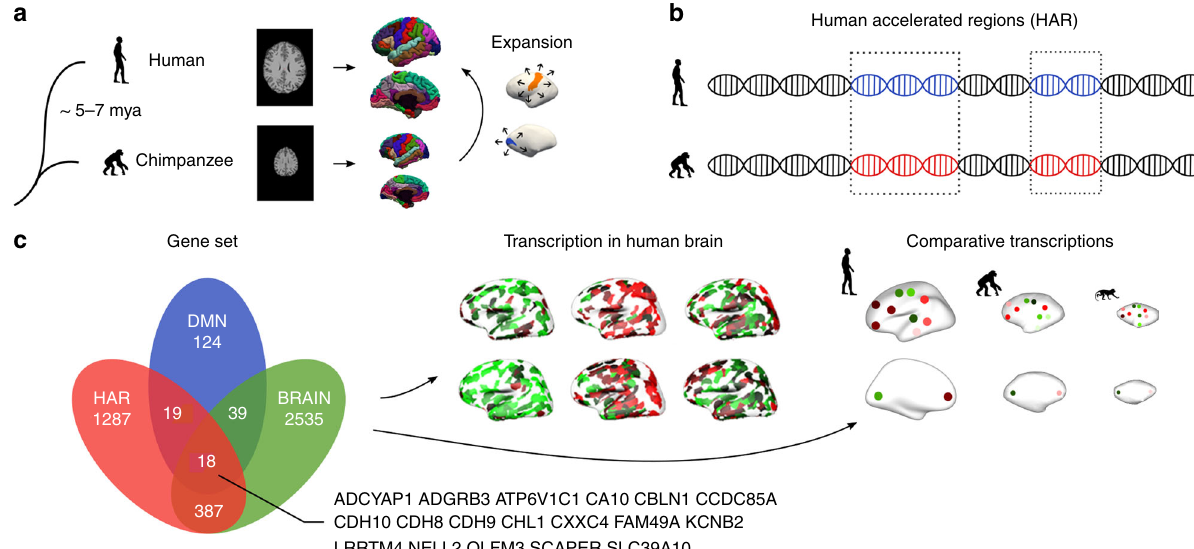
Fig. 1 Methods overview. a The human and chimpanzee cortex were constructed using MRI data, with chimpanzee-to-human cortical expansion computed based on the reconstructed cortical maps. b Genes associated with human accelerated regions (HAR), which represent genomic loci with accelerated divergence in humans, were examined. c Cortical gene expression of HAR genes and HAR-BRAIN genes were examined using human transcription data from the Allen Human Brain Atlas (AHBA) and comparative transcription data of the human, chimpanzee, and macaque from the PsychENCODE database